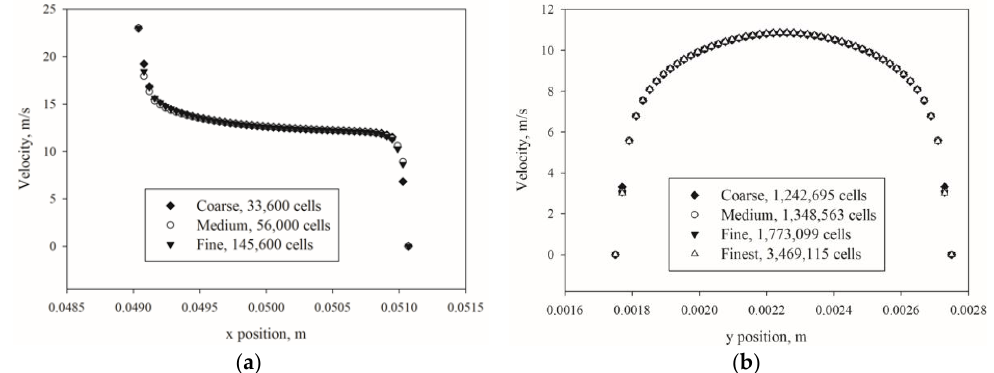
Figure 2. Determination of cell count for grid independence: ( a ) Grid independence analysis for Couette viscometer for highest shear stress (450 Pa) experiment by using k -ε model (Bottom row in Table 1); ( b ) grid independence analysis for capillary tube for the highest shear stress (400 Pa) experiment by using k -ω SST model (Bottom row in Table 2).